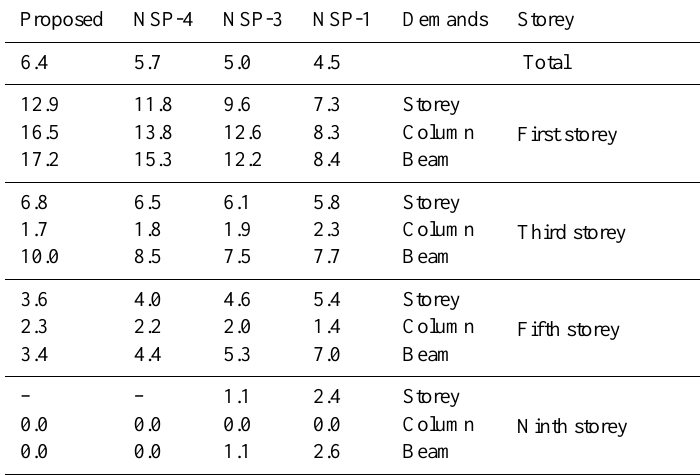
Table 8. Summary of ductility demands for 10-storey